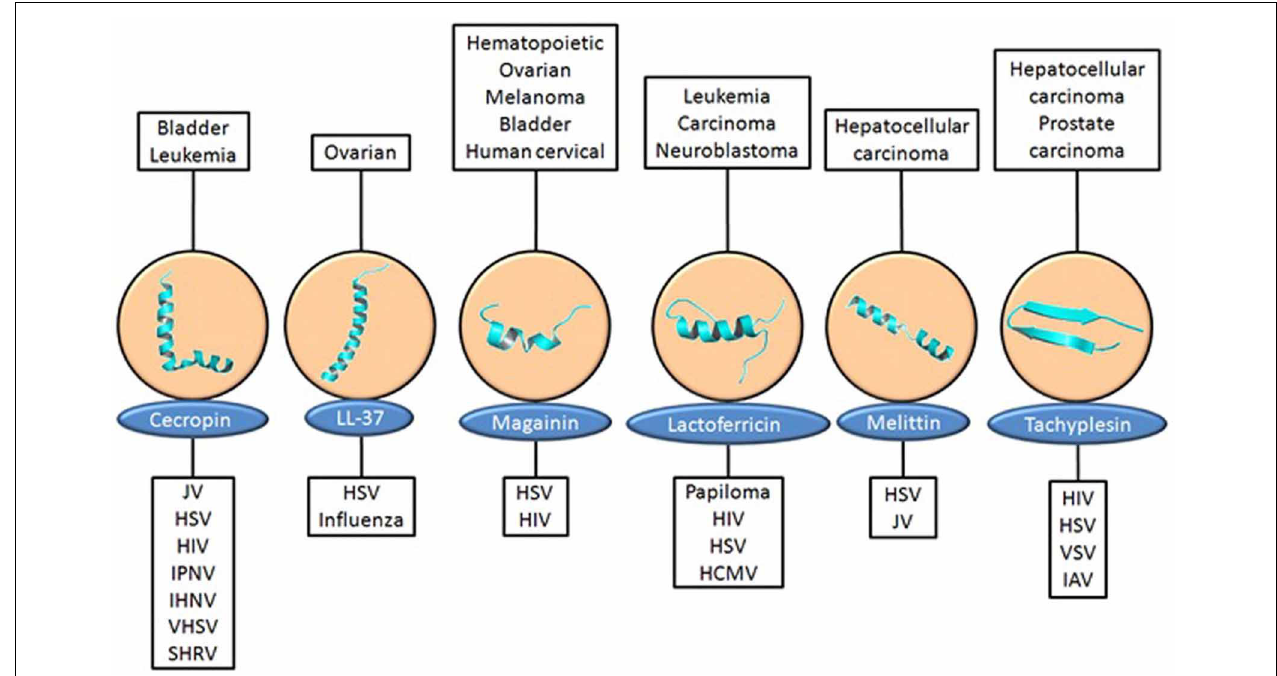
FIGURE 2 | Promiscuous cationic peptides with antitumor and antiviral activities. Each promiscuous peptide and their various tumors against which present cytotoxic activity (top) and viruses against which present antiviral activity (bottom) . #PDB from left to right, 2IGR, 2K6O, 2LSA, 1Z6V, 2MLT, 1WO1. HCMV, human